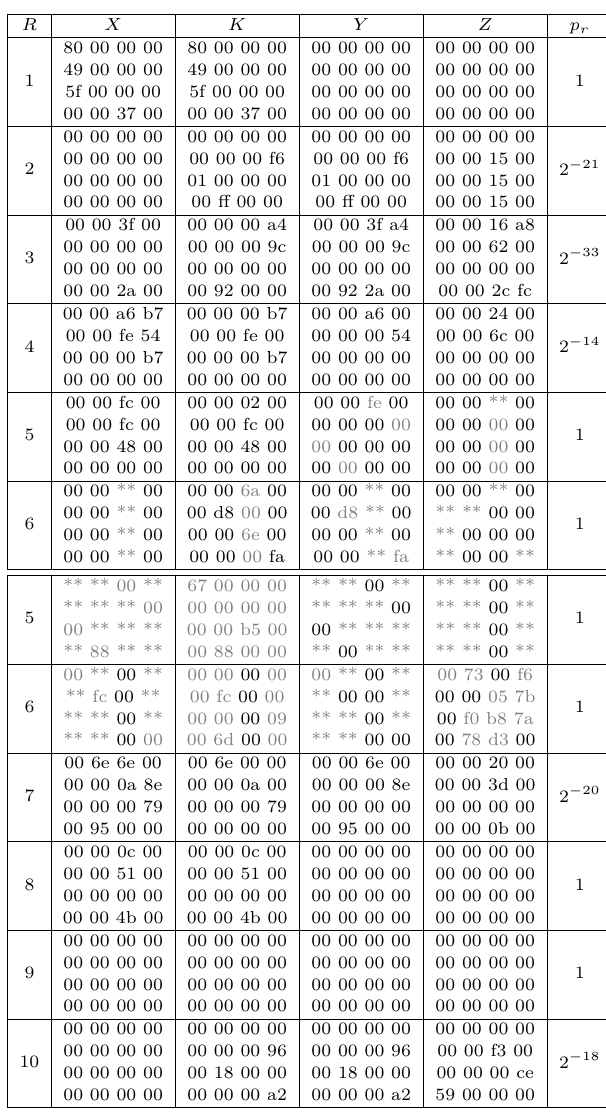
Table 9: 10-round distinguisher of